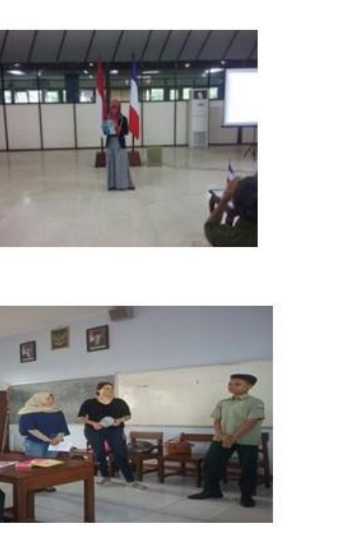
Figure 1 Des activités de Warung Prancis